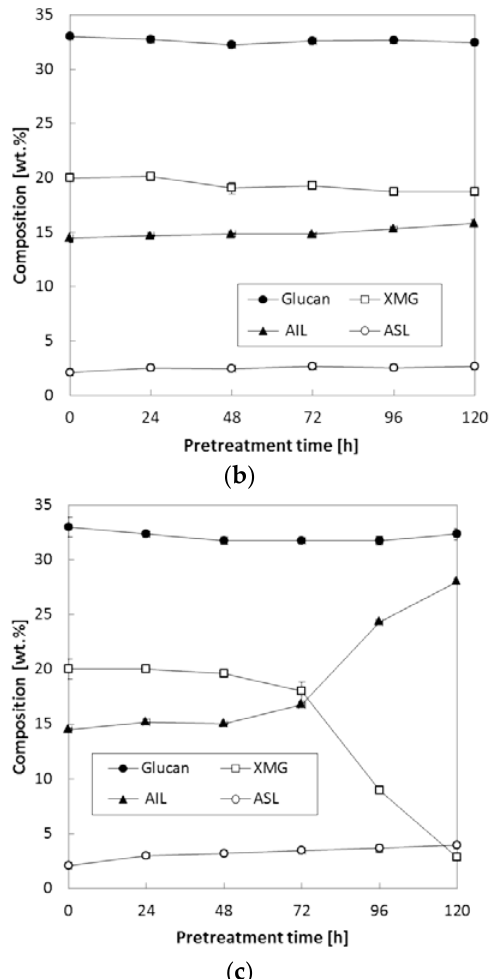
Figure 3. Effects of the S/L ratio on composition of corn stover. Pretreatment: 150 °C, 24–120 h, 0.08 (g NH 3 )/(g biomass) ( a ) S/L ratio = 0.29, ( b ) S/L ratio = 0.47, ( c ) S/L ratio = 0.67. The data in the figure show mean values.